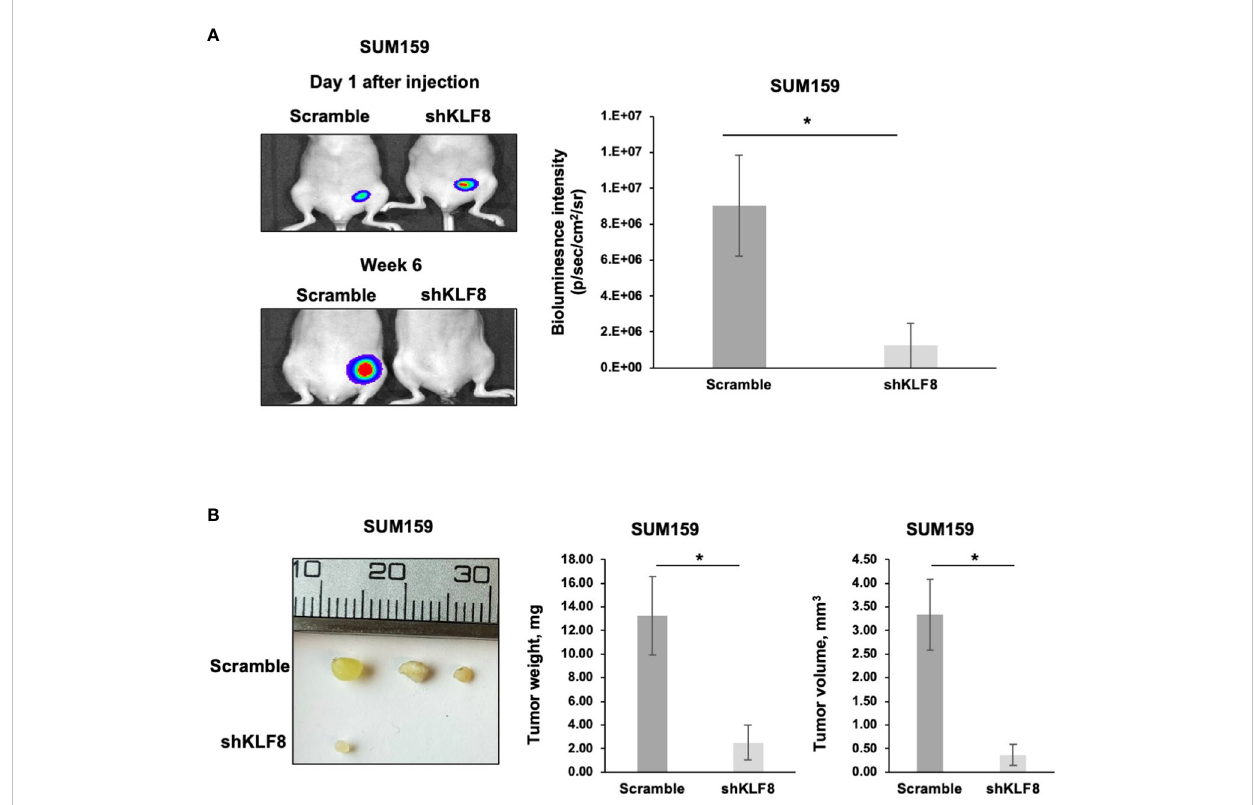
FIGURE 6 Reduced KLF8 expression impaired breast tumor growth in vivo . (A) Representative images of tumors in immune-compromised mice, formed from MDA-MB-231 cells stably expressing luciferase, transduced with control or KLF8 shRNA 1 day and 6 weeks after injection (left). Quanti fi ed graph showing bioluminescence signal from tumors formed from MDA-MB-231 cells stably expressing luciferase, transduced with control (n=4) or KLF8 (n=4) shRNA, 6 weeks after injection (right). (B) Representative images of tumors formed from MDA-MB-231 cells stably expressing luciferase, transduced with control or KLF8 shRNA, taken from mammary fat pad of immune-compromised mice 6 weeks after injection (left). Quanti fi ed graph showing weight of tumors formed from MDA-MB-231 cells stably expressing luciferase, transduced with control (n=4) or KLF8 (n=4) shRNA (middle). Quanti fi ed graph showing volume of tumors formed from TNBC cells MDA-MB-231 stably expressing luciferase, transduced with control (n=4) or KLF8 (n=4) shRNA (right). Student t test reported as mean ± SEM,